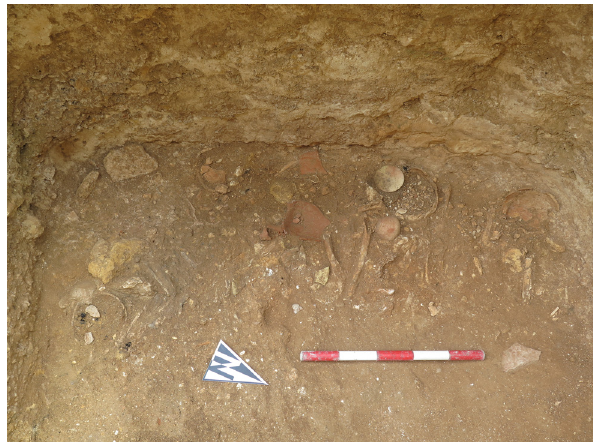
Figure 4: Uncovering of early phase I with skeletons 1 and